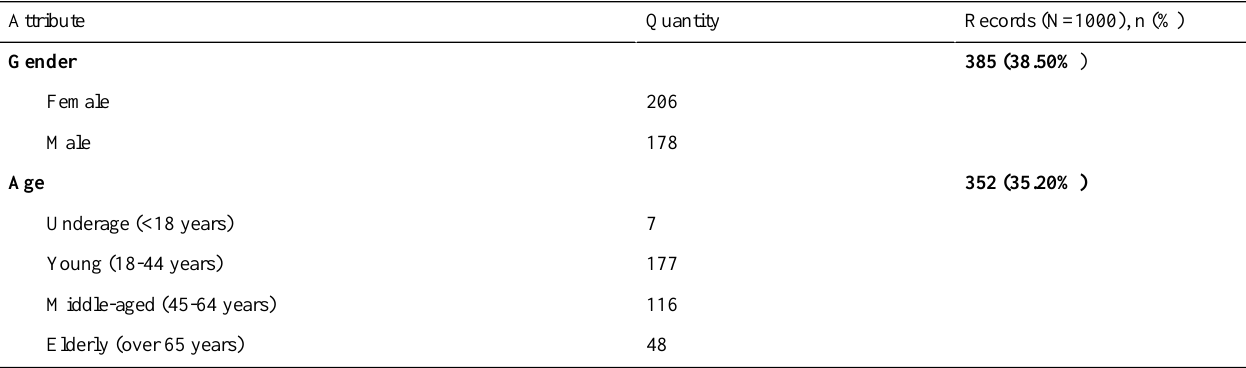
Table 2. Distribution of identified demographic data of the patients with